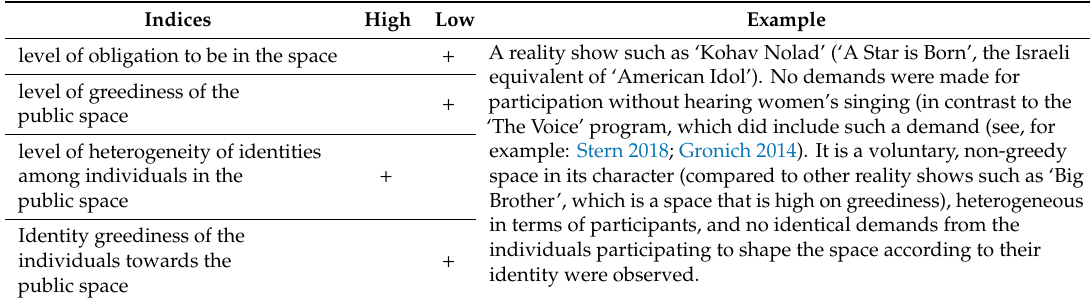
Table A6. Low potential confrontation.